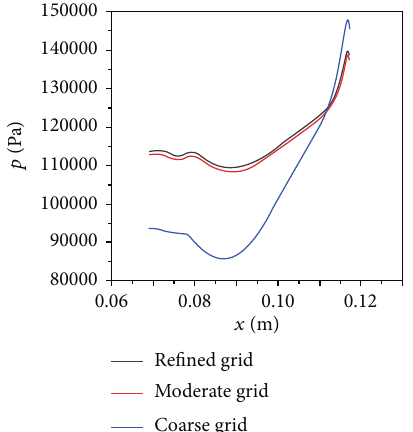
Figure 4: Wall pressure distributions in the centerline of the cavity bottom using di ff erent